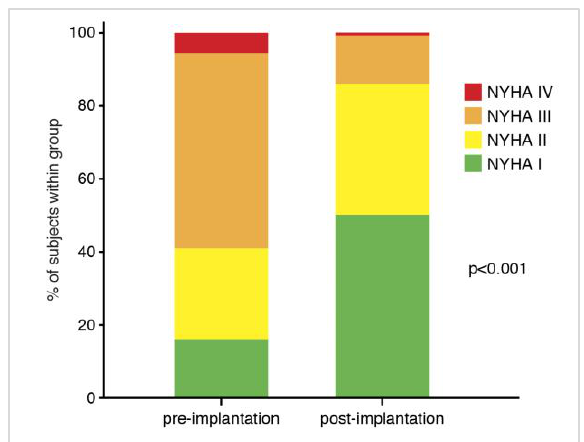
Figure 1: Clinical effects of cardiac resynchronisation therapy (CRT). Distribution of New York Heart Association (NYHA) class before and after CRT implantation (data available in 305 patients, 73%). Median follow-up time of 6 months. Wilcoxon signed rank test.